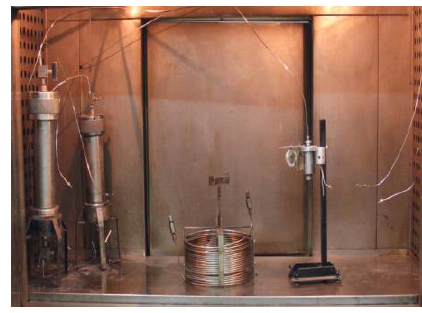
Figure 2. Slim-tube experimental device. Table 2. The parameters of slim-tube.